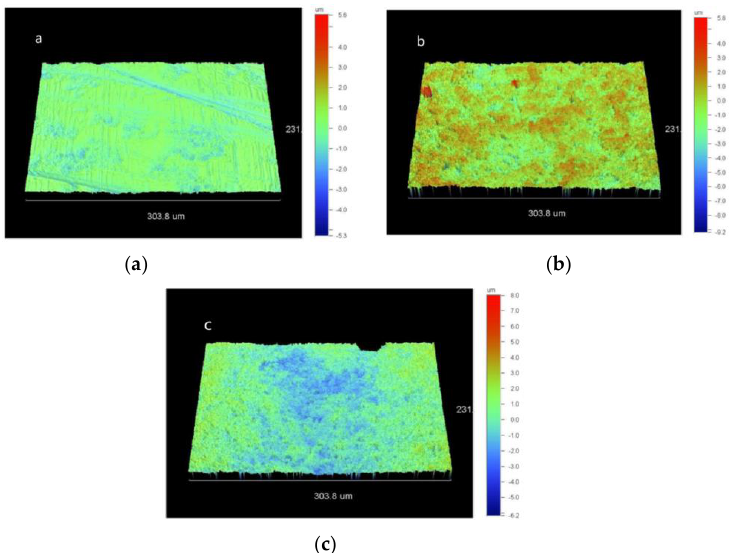
Figure 2. Representative 3D-profilometric images of CL ( a , scale range: 5.6 to −5.3 μm), AL ( b , scale range: 5.8 to −9.2 μm) and SJ ( c , scale range: 8 to −6.3 μm) treated zirconia surfaces (20× magnification).